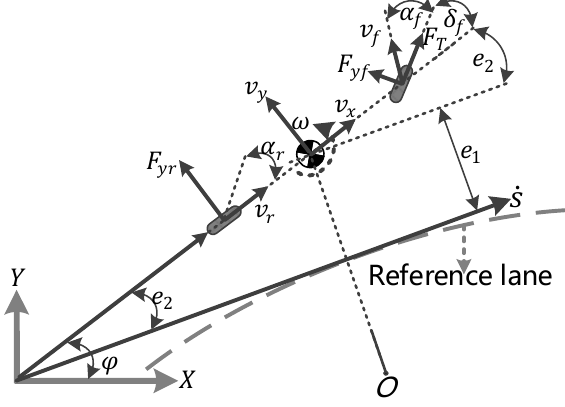
Figure 3. Coupling dynamics model schematic.